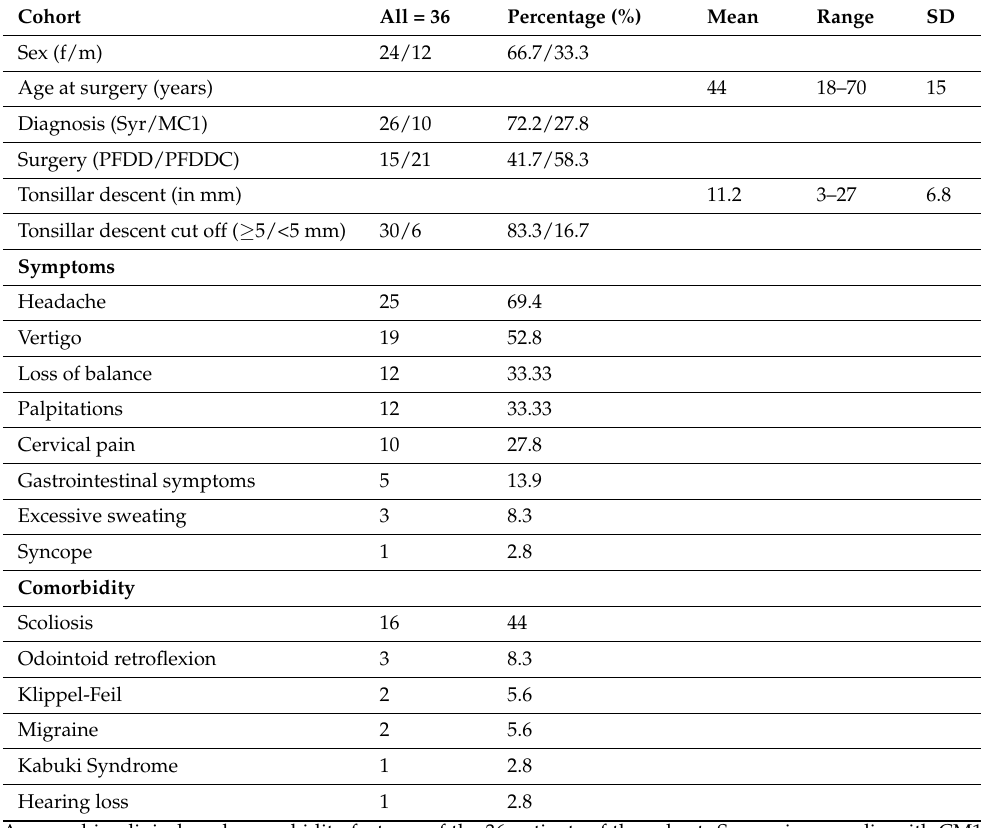
Table 2. Demographic and clinical variables in the study